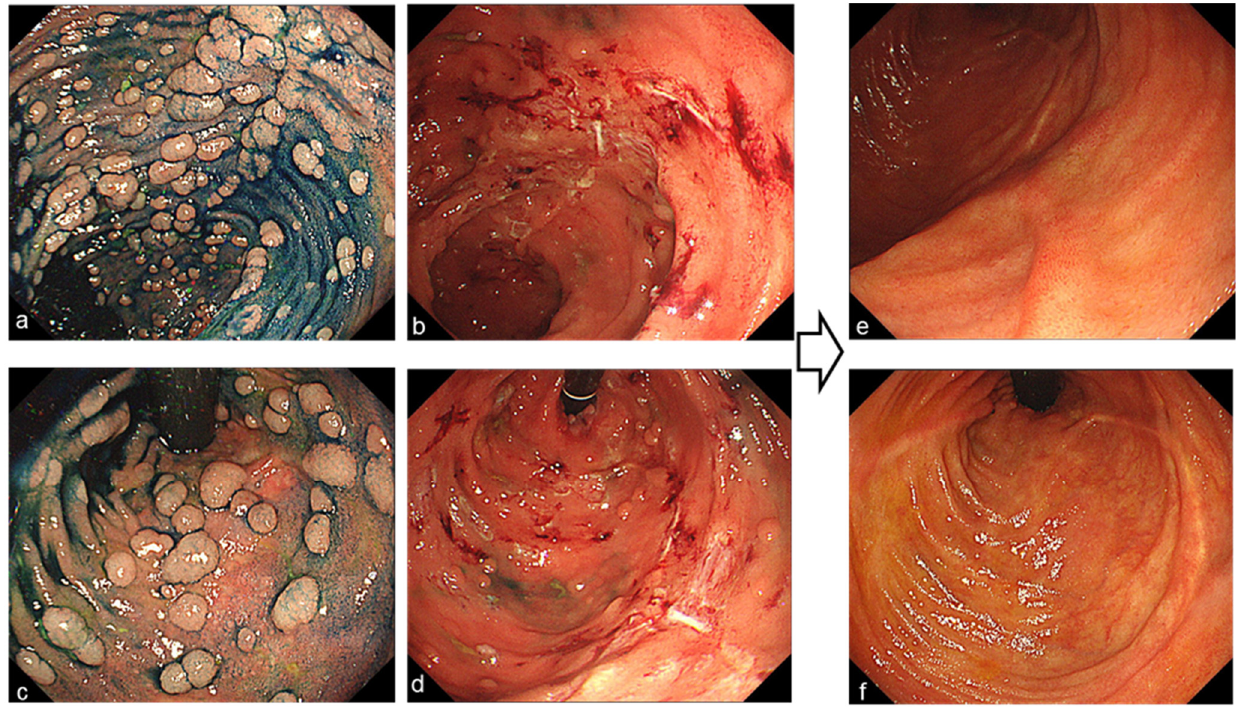
Figure 1. ( a , c ) Endoscopic image of polyposis in an ileal pouch (( a ) oral side, ( c ) anal side) with indigo-carmine. ( b , d ) Endoscopic images during endoscopic mucosal resection and cold-snare polypectomy. ( e , f ) Endoscopic images 12 months after 2 endoscopic treatments.